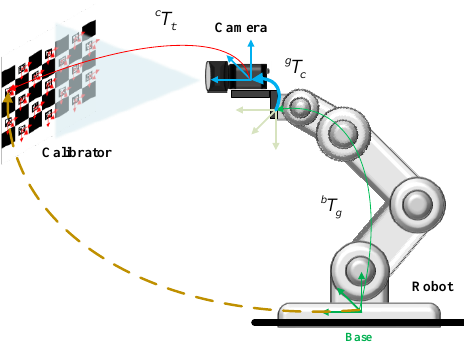
Figure 6. Schematic diagram of the positional relationship between the ChArUco board and the robot.